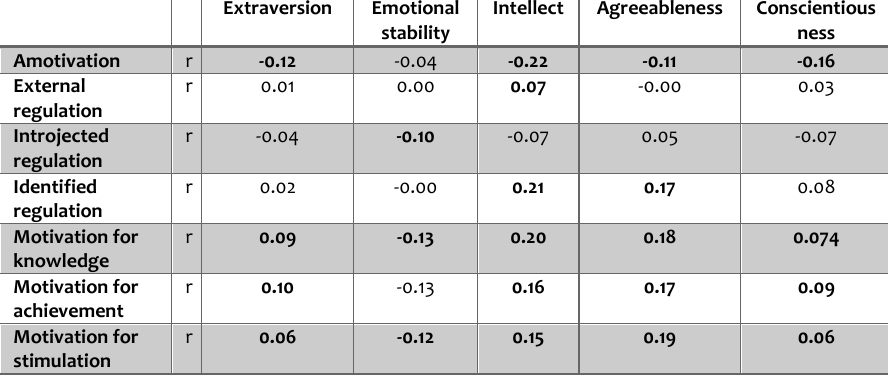
Table 2. R- parameter indicating the correlation between L2 learning motivation and personality traits